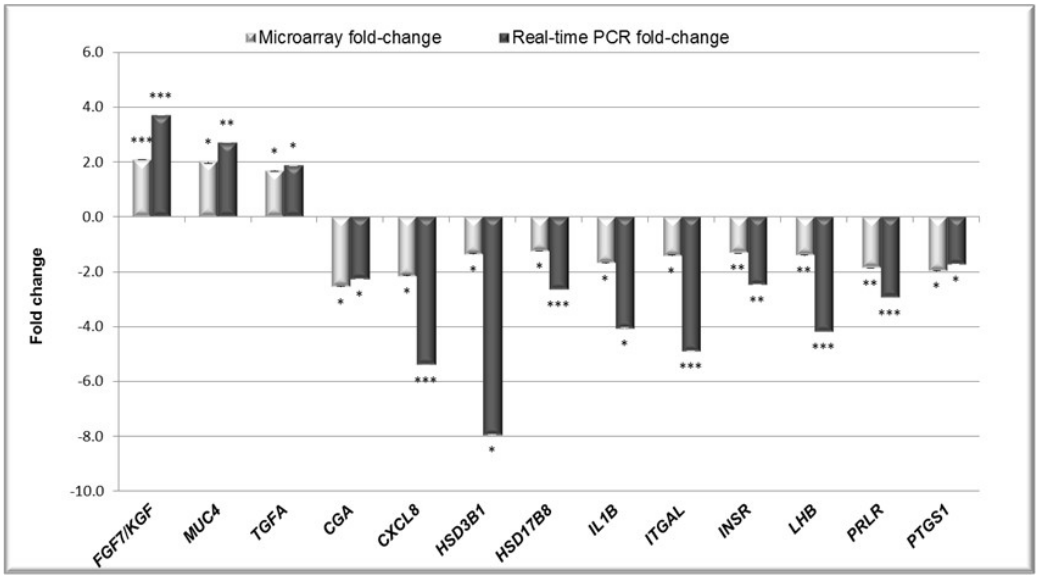
Figure 2. Real-time PCR validation of the microarray experiment. Light-grey bars represent fold changes for microarray data; dark-grey bars represent fold changes for qPCR data. Data are presented as means ± SEM from four different observations; * p < 0.05; ** p < 0.01; *** p < 0.001.